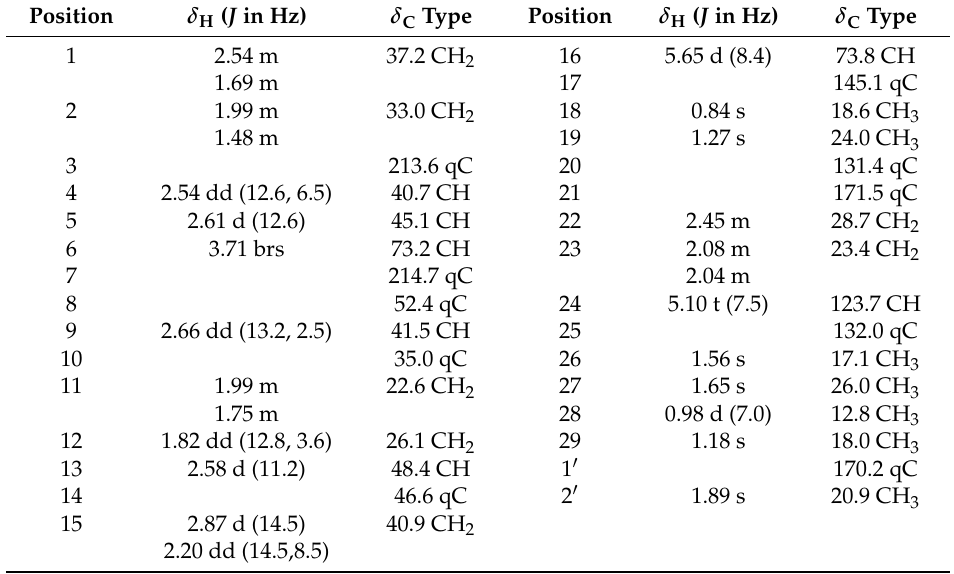
Table 2. The 1 H and 13 C data of compound 6 (DMSO- d 6 , 700 MHz and 175 MHz in δ ppm).